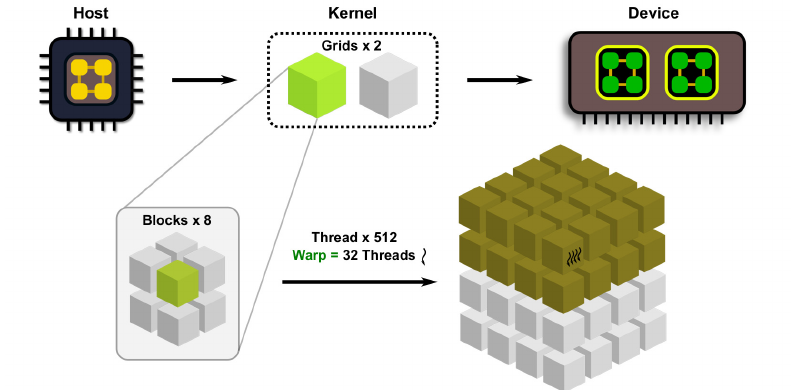
Figure 3. GPU instruction cycle and Compute Unified Device Architecture (CUDA)